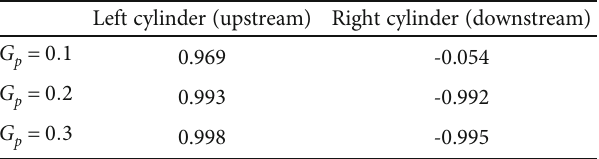
Table 4: Correlation between drag and lift. Left cylinder (upstream) Right cylinder